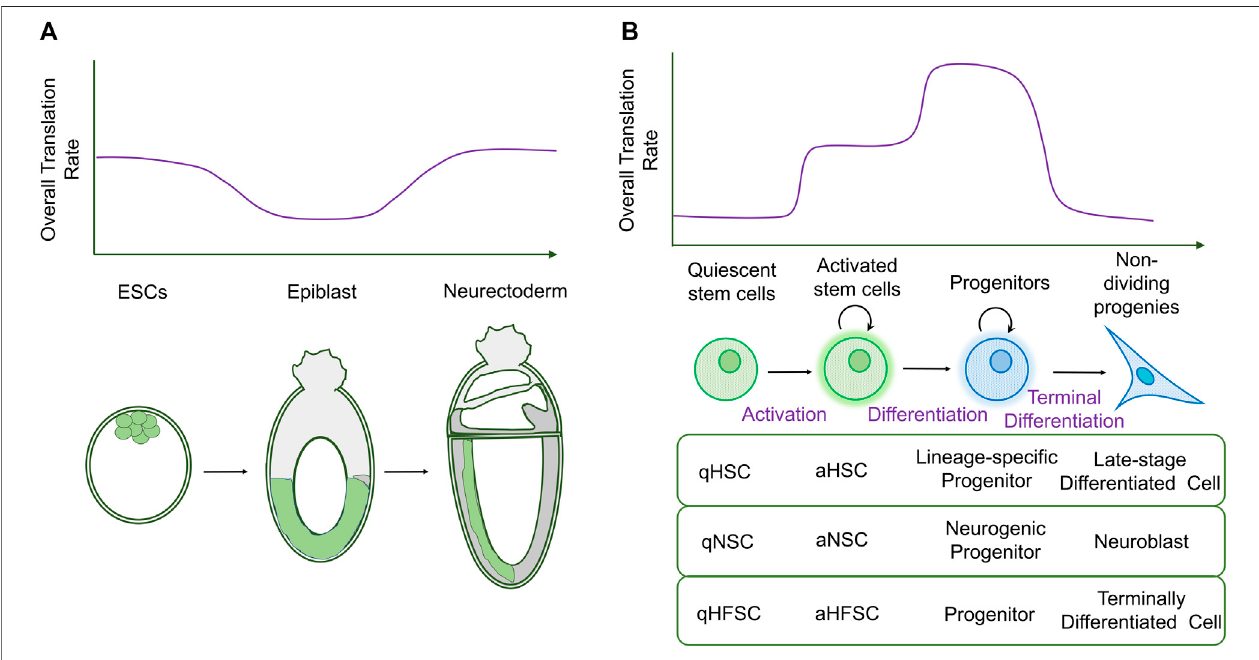
FIGURE 1 | Changes in global translation during stem cell differentiation. (A) Diagram schematizing bulk translation rates during early mammalian embryogenesis (top),withstagesshownlater.BulktranslationratesareinitiallyhighinESCsanddecreaseduringdifferentiationintotheepiblast.Globaltranslationlevelsriseagainduring neurectodermaldevelopment. (B) Inadultstemcells,quiescentstemcellshavelowratesofbulktranslation.Translationincreasesinactivatedstemcellsandishighestin proliferating progenitors that initiate differentiation. Terminally differentiated cells display low rates of translation. The table shows examples of stem cells in which translation rates follow this pattern: hematopoietic stem cells (HSCs), neural stem cells (NSCs), and hair follicle stem cells (HFSCs). q: quiescent; a: